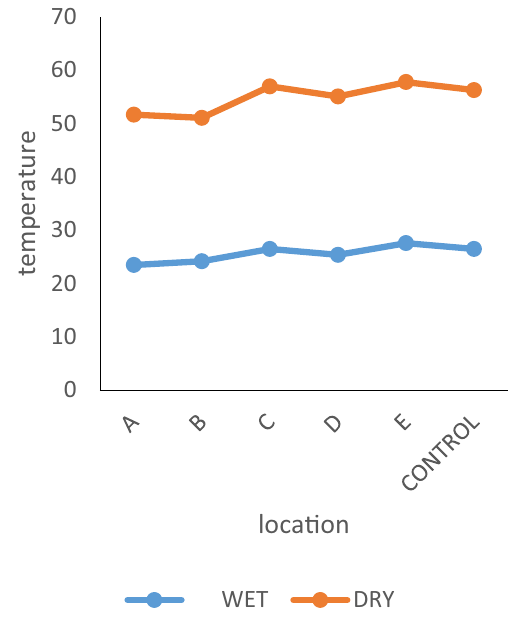
Fig. 3 The chart of temperature variation across the locations